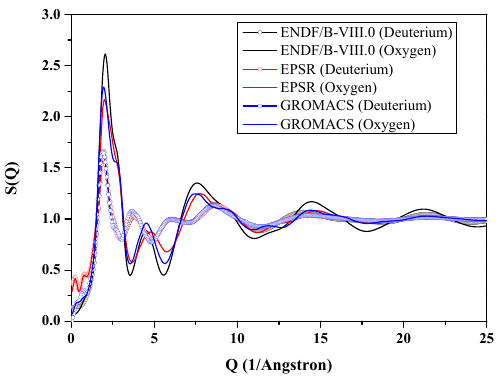
Fig. 1. Comparison of Sköld correction factors obtained from the ENDF/B-VIII.0 data and calculated by the EPSR and GROMACS code